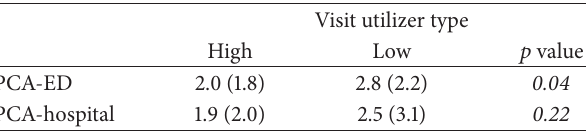
Table 3: Change in ED pain score a by site of PCA initiation and visit utilizer type, mean